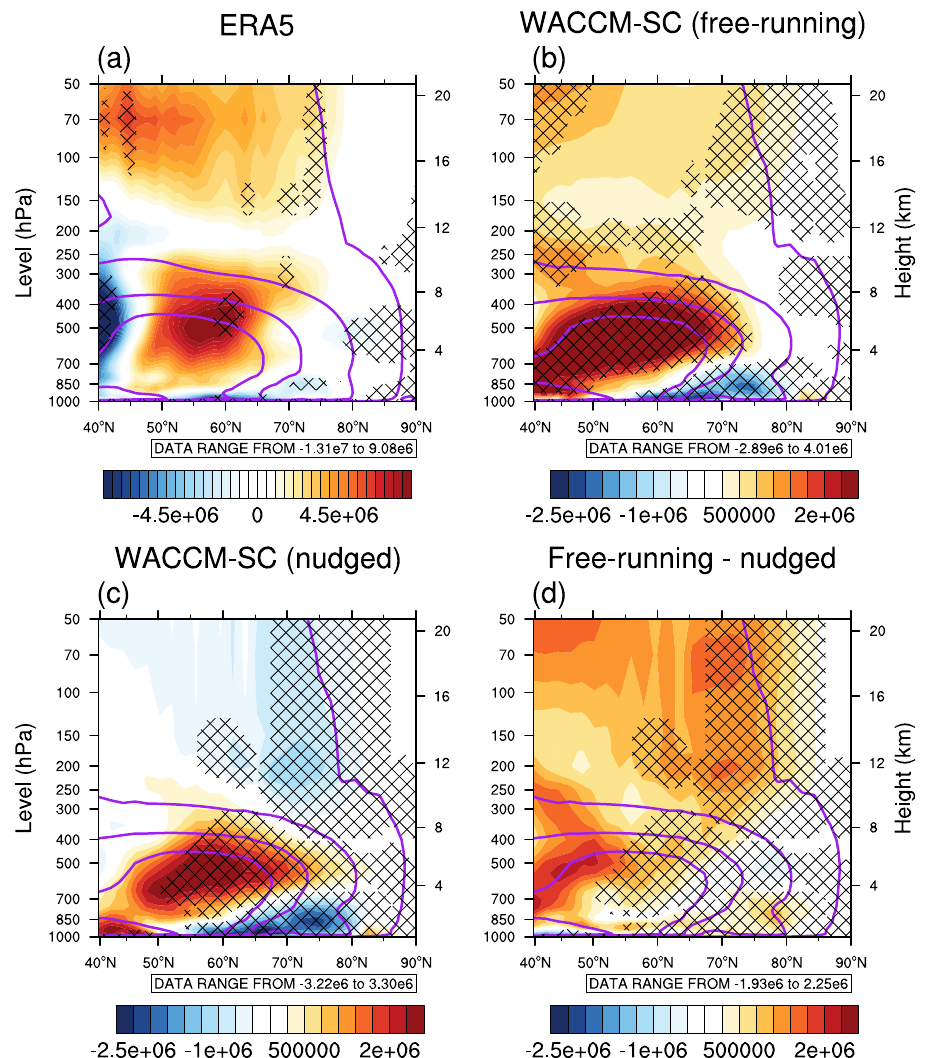
Fig. 3 Winter residual stream function anomalies induced by BKS sea-ice loss. a Zonal-mean winter residual meridional stream function (kg m − 1 s − 1 ; scaled by air pressure) regressed against BKS sea ice, multiplied by the composited SIC differences between BKS low- and high- SIC years, derived from the ERA5 reanalysis. Simulated differences of zonal-mean winter residual meridional stream function between LICE and HICE runs in the b free-running WACCM-SC simulations, c nudged WACCM-SC simulations, and d their differences (free-running minus nudged). Purple contours denote the climatological state of residual meridional stream function for ERA-5 reanalysis and WACCM-SC simulations. The information of data range is placed above label bar. Hatched regions are statistically signi fi cant at the 90% con fi dence level according to bootstrap resampling statistical